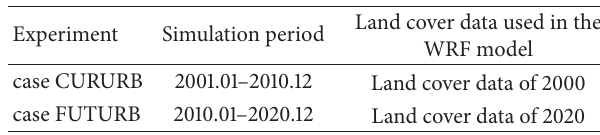
Table 3: Schemes of the simulation